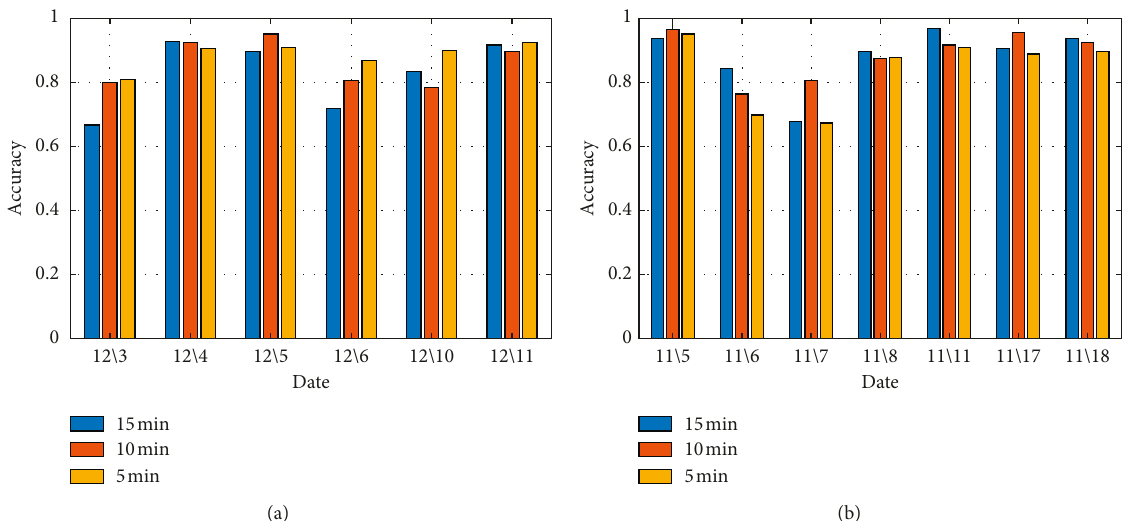
Figure 7: Accuracy of each day’s classification determined by the wet-dry classifiers at three resolutions constructed by two sets of training data. (a) December. (b)